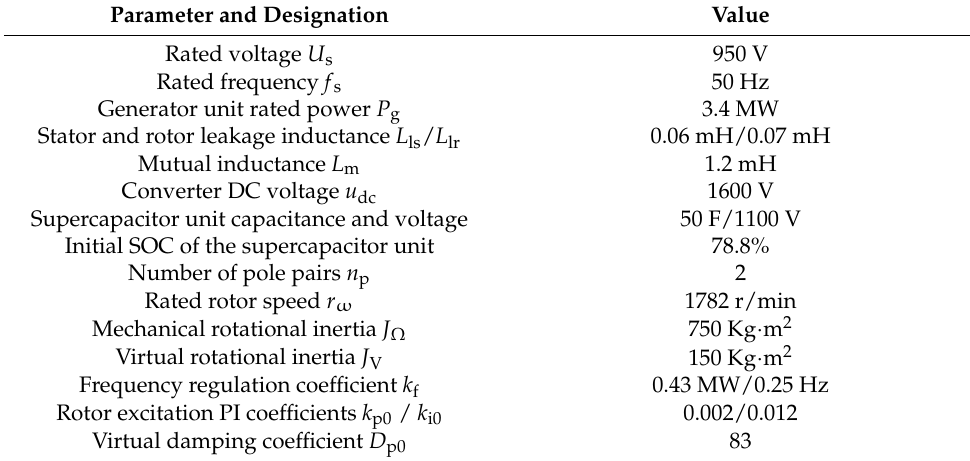
Table 1. Key Parameters of the DFIG-VSG System.